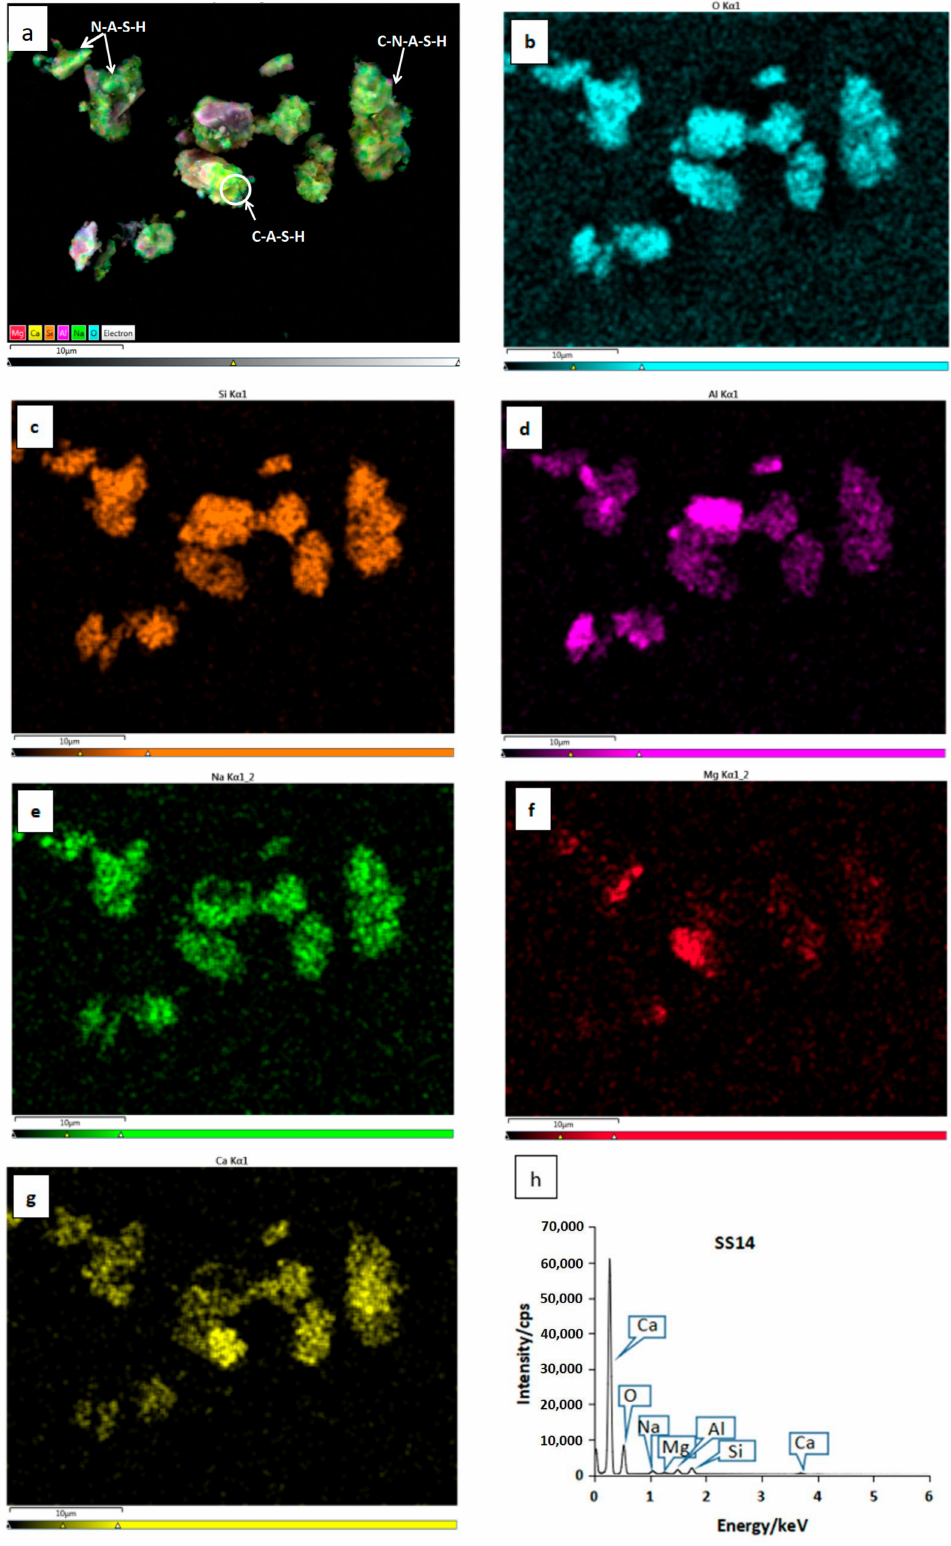
Figure 15. Element distribution diagram and EDS spectrum of SS14. ( a ) General distribution of major elements, ( b ) O element, ( c ) Si element, ( d ) Al element, ( e ) Na element, ( f ) Ca element, ( g ) Mg element, ( h ) EDS